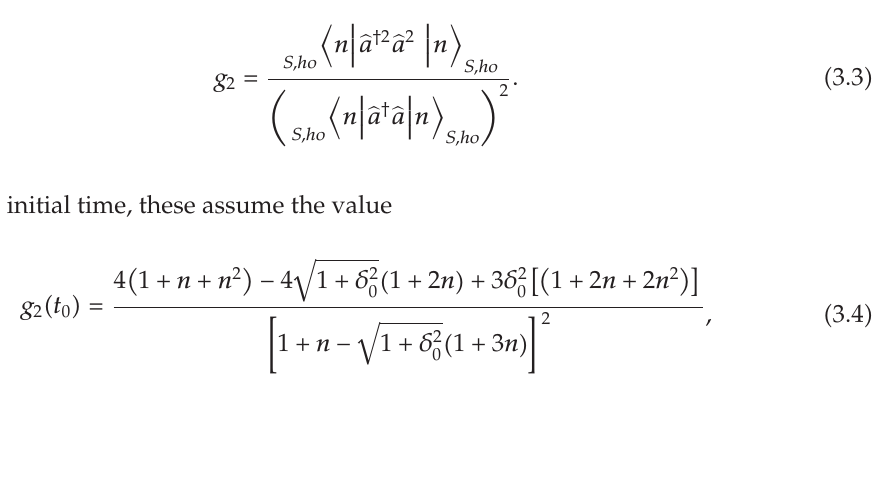
greater; and (cid:4) iii (cid:5) as functions of δ 0 , the P n → n ’s exhibit a pair of extremals, although as a kind of very marginal e ff ect (cid:4) see Figures 2 and 3 (cid:5)